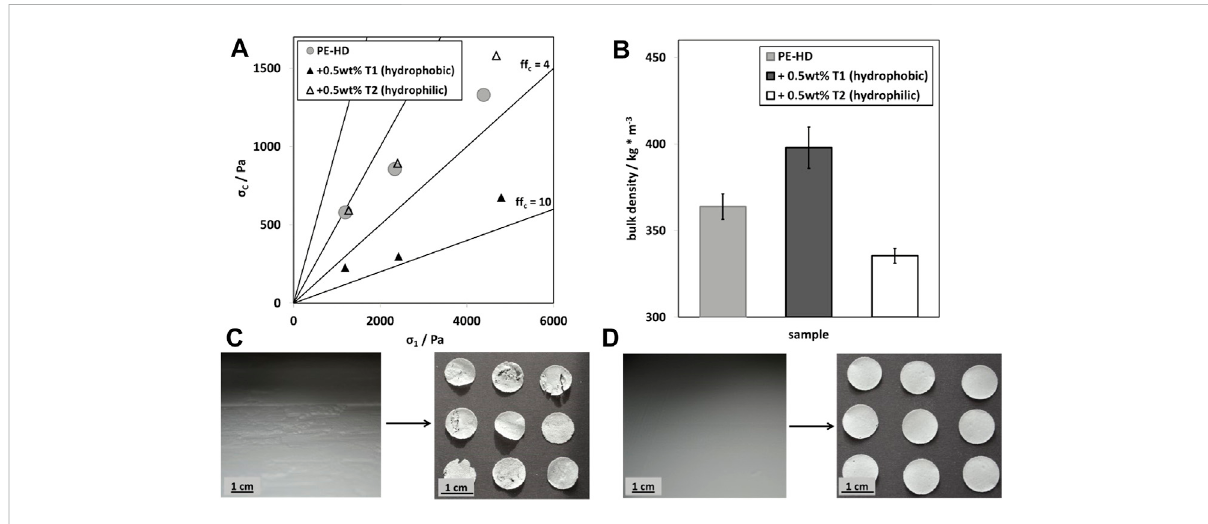
FIGURE 7 Effect of choice of fl owing aid (hydrophobic silica T1 vs. hydrophilic silica T2) used to prepare PE-HD-silica composite powders on (A) fl owability, (B) bulk density, spreadability (Figures 7 (C,D) T1 vs. T2) under PBF process conditions and specimen characteristics (Blümel et al., 2015).